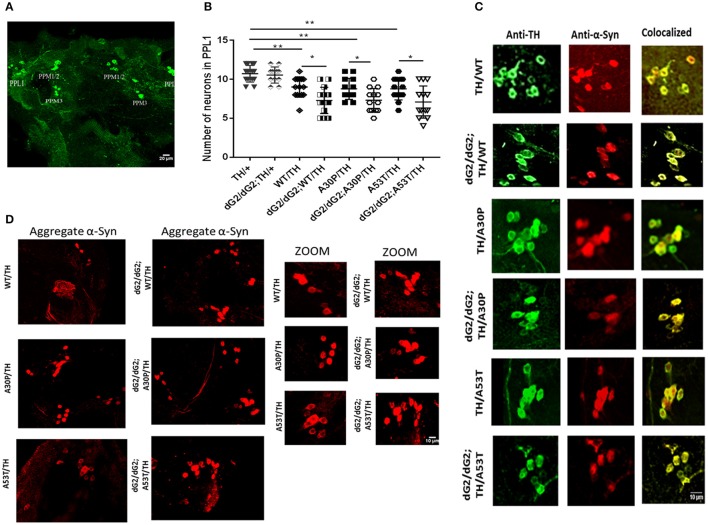
Increased neurodegeneration in dG2/dG2 flies expressing WT, A30P, and A53T synuclein. (A) Representative image of a projected Z-series of 30 day-old control fly brain with TH-Gal4 driver stained with anti-Tyrosine Hydroxylase (TH) to identify dopaminergic (DA) neurons. DA neurons within each cluster are indicated by labels. (B) Relative number of DA neurons within the PPL1 cluster of 30 day-old dG2/dG2 RNAi flies under control of TH-Gal4 driver expressing WT, A30P, A53T synuclein (n = 16), compared to age-matched corresponding control flies without dG2/dG2 RNAi (n = 16). There was also significant decrease in number of DA neurons in flies expressing α-syn (WT/A30P/A53T) compared to control TH/+ flies. Differences in means were compared by one-way ANOVA followed by the Newman-Keuls Multiple Comparison post hoc test. ** represents p < 0.001, *p < 0.05. (C) Representative image of projected Z-series of PPL1 cluster in 30 day-old fly brain with under control of TH-Gal4 driver co-stained with anti-TH (green) and anti-syn antibody (red) confirms expression of α-syn in DA neurons in different genotypes. (D) Representative immunofluorescent staining of 30 day-old fly brain expressing WT, A30P, and A53T synuclein (TH-Gal4 UAS transgenes) with/without GBA silencing stained with conformational antibody (anti-α-synuclein filament antibody) for α-syn aggregates.